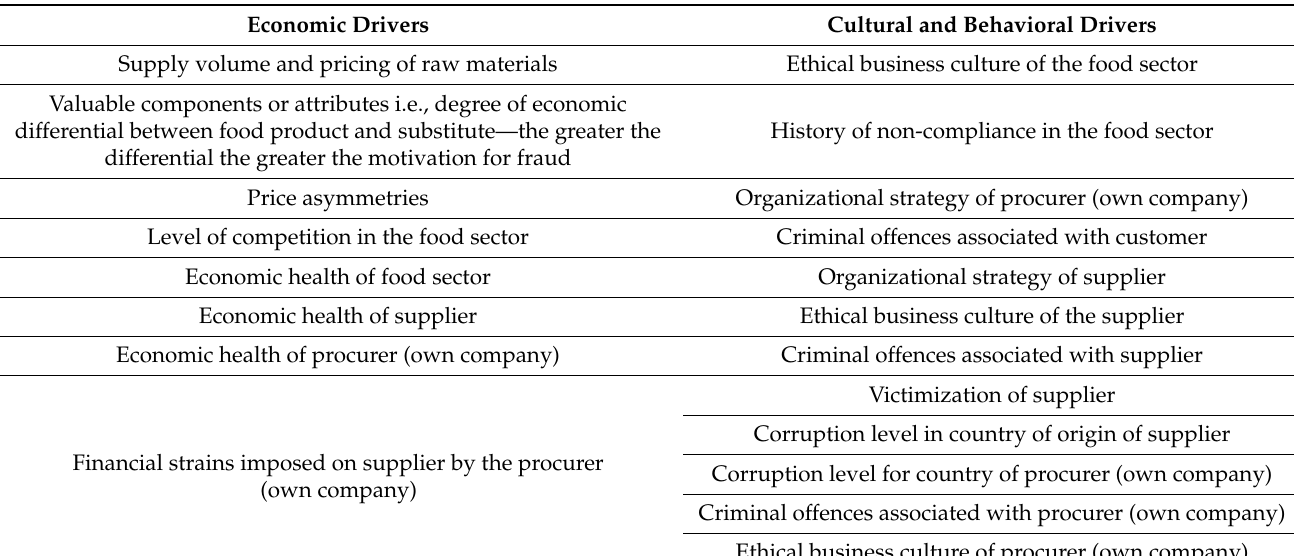
Table 1. Motivating factors that influence food fraud in the organic sector (adapted from: [15]). Economic